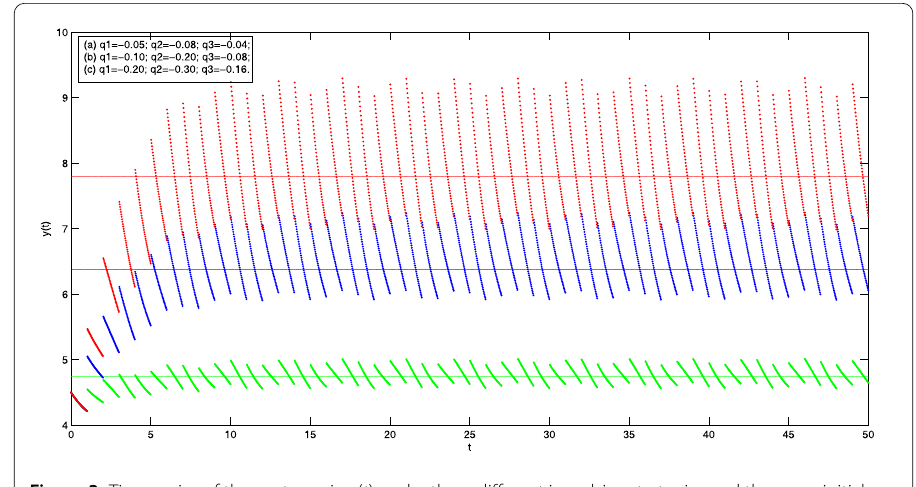
Figure 3 Time-series of the pest specie y ( t ) under three different impulsive strategies and the same initial values